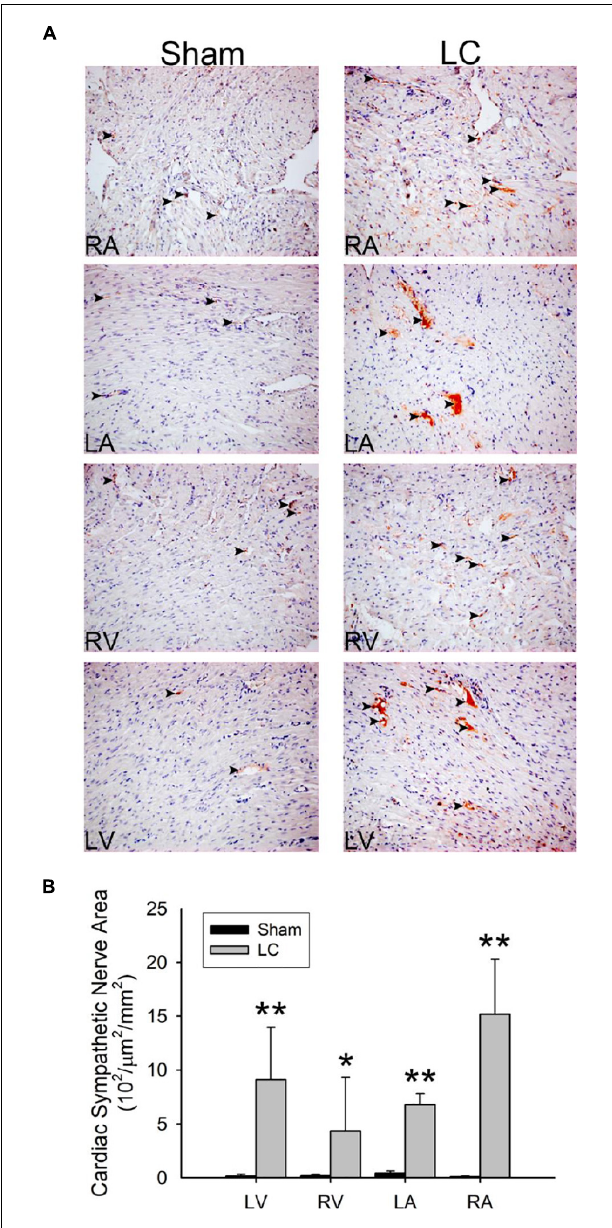
FIGURE 4 | Tyrosine hydroxylase stain for sympathetic innervation of the myocardium. (A) The immunohistochemistry stain (magnification 200 × ) for tyrosine hydroxylase of the atrial and ventricular myocardium in the sham and LC groups. The tyrosine hydroxylase stain showed an increased sympathetic innervation (denoted in black arrowheads) in the LC group compared with the sham group. (B) The comparison of the total area of sympathetic innervation in the myocardium between the sham and LC groups. ** p < 0.01, compared with the sham group. * p < 0.05, compared with the sham group.